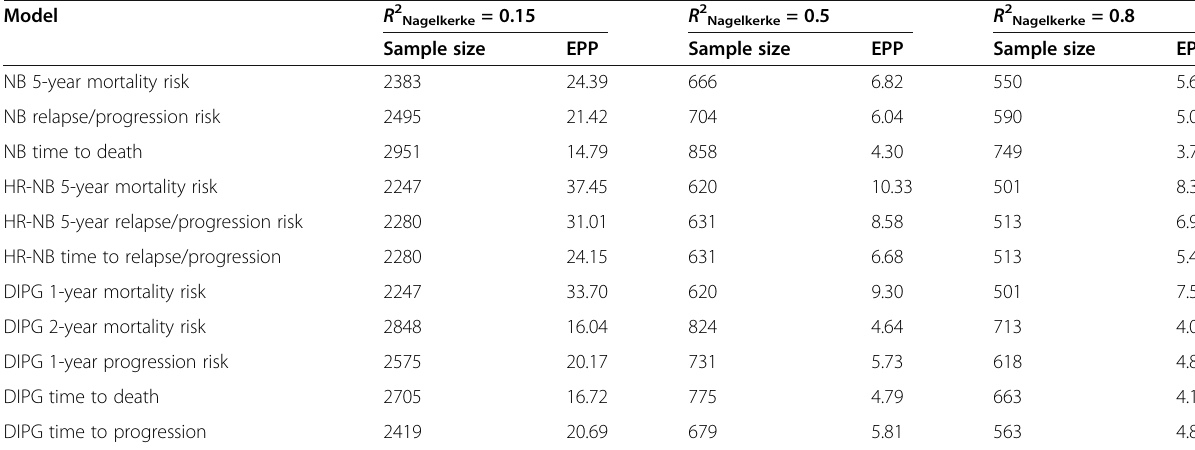
Table 4 Variability of sample size with R 2 Nagelkerke